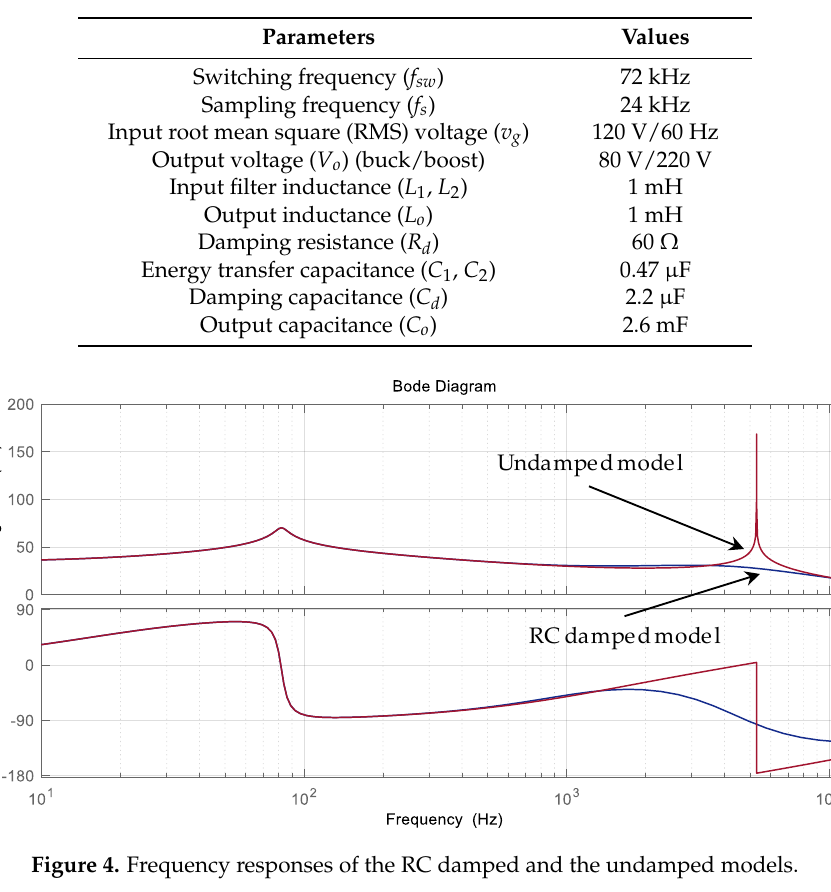
Figure 4. Frequency responses of the RC damped and the undamped models.